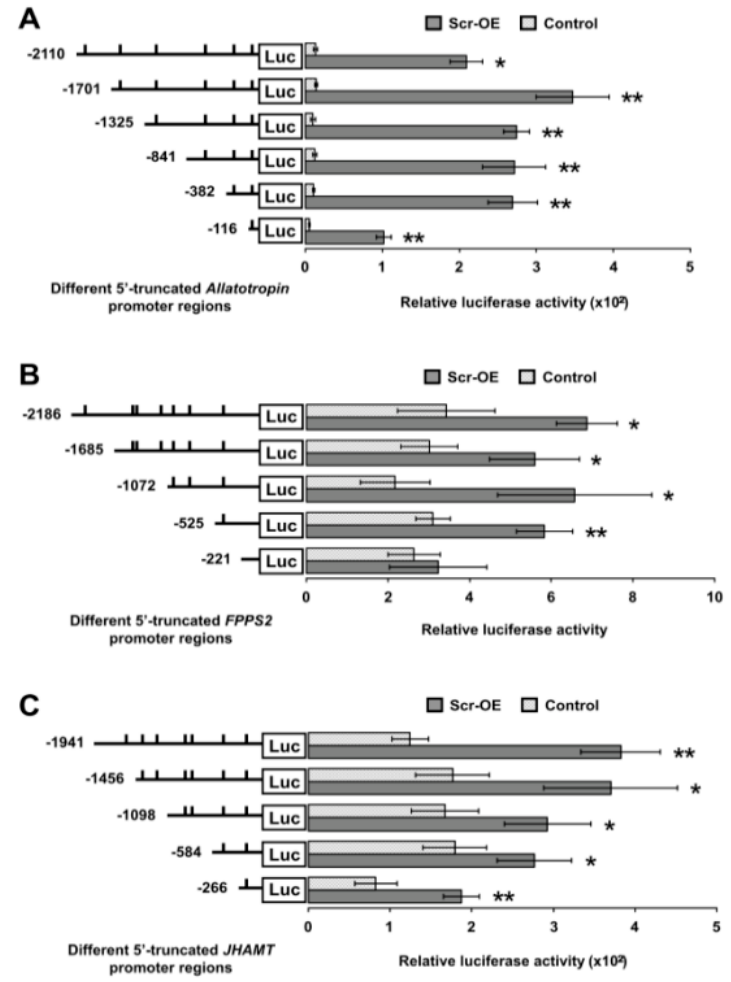
Figure 8. Truncation analysis of Scr-mediated activities of the promoters of genes involved in JH biosynthesis. ( A ) The effects of Scr overexpression on the luciferase expression driven by several 5 ʹ -truncated promoters of the Allatotropin gene. Luciferase reporter analysis in BmE cells indicated that every truncated promoter of Allatotropin significantly increased the luciferase expression after Scr overexpression; ( B ) The effects of Scr overexpression on the luciferase expression driven by several 5 ʹ -truncated promoters of the FPPS2 gene. Luciferase reporter analysis in BmE cells indicated that the four longer truncated promoters of FPPS2 significantly increased the luciferase expression after Scr overexpression, whereas the increase was not significant when the luciferase expression was driven by the shortest truncated promoter; ( C ) The effects of Scr overexpression on the luciferase expression driven by several 5 ʹ -truncated promoters of the JHAMT gene. The luciferase reporter analysis in BmE cells indicated that every truncated promoter of JHAMT significantly increased the luciferase expression after Scr overexpression. The predicted CREs for homeodomain transcription factors are indicated by short lines. Luc, luciferase; OE, overexpression. The error bars represent the mean ± S.E. ( n = 3). The significance of the difference between data sets was calculated using two-tailed Student’s t -test. * p < 0.05; ** p < 0.01, compared with the control.